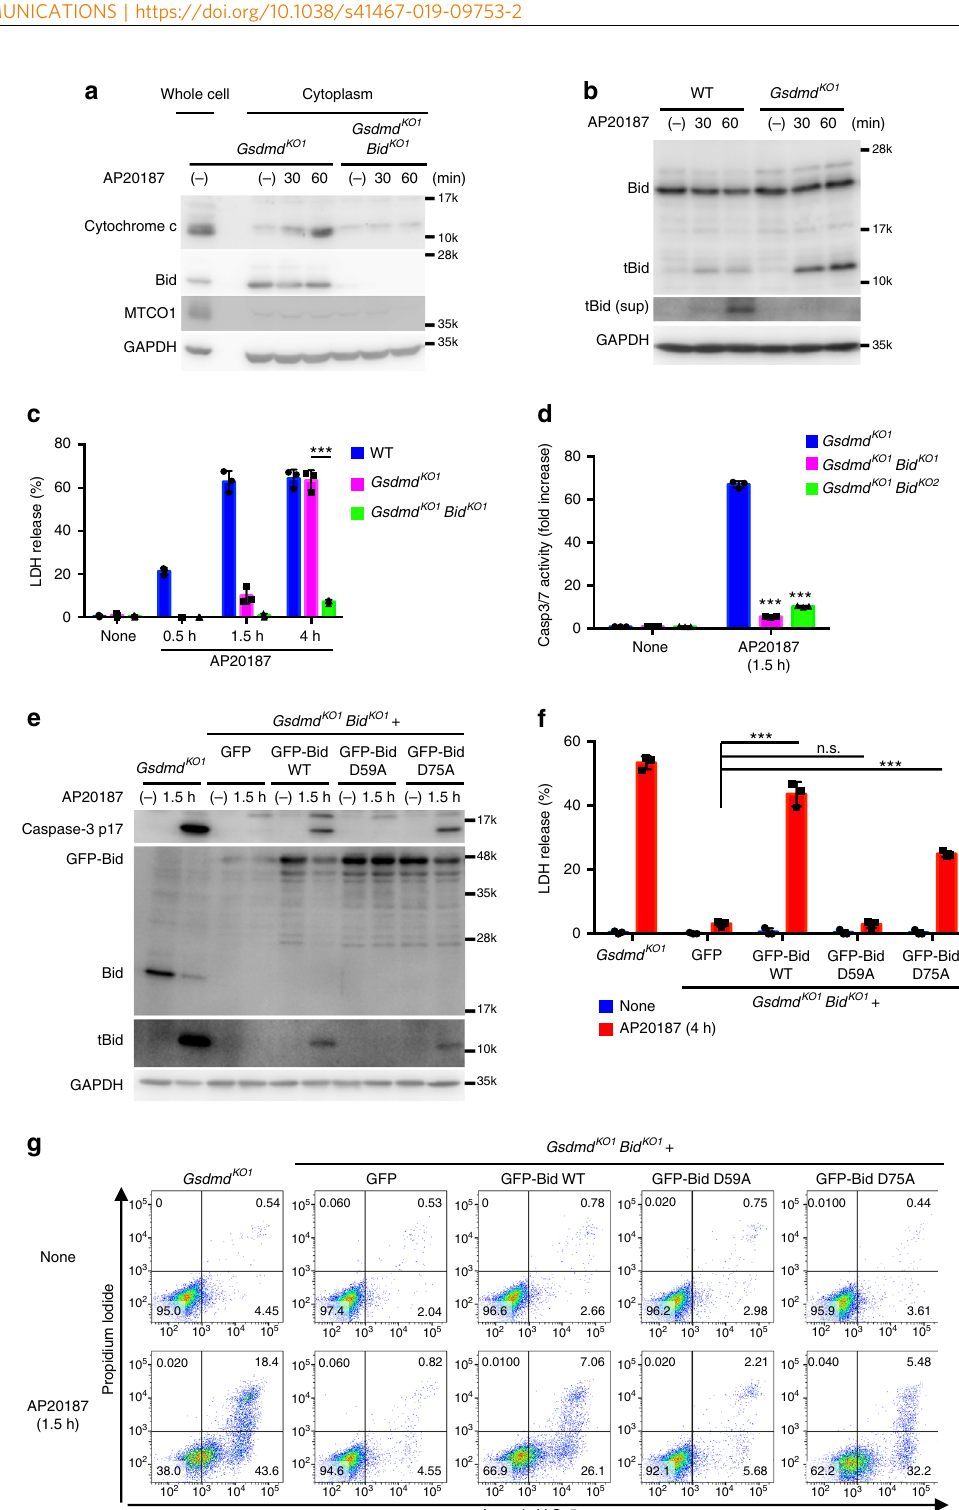
Fig. 6 Bid plays a critical role in caspase-1-induced apoptosis. a – d WT, Gsdmd -KO or Gsdmd / Bid -DKO CL26-iCasp1 cells were treated with AP20187 for the indicated times. Cytochrome c, Bid, GAPDH (cytosolic marker) and MTCO1 (mitochondrial marker) in the whole cell lysates or cytosol fractions were detected by western blotting ( a ). Bid in the cell lysates and culture supernatants (sup) was detected by Western blotting ( b ). LDH release into culture supernatants ( c ). Caspase-3/7 activity in the cell lysates. e – g Gsdmd -KO CL26-iCasp1 cells and Gsdmd / Bid -DKO CL26-iCasp1 cells stably transfected with GFP, GFP-Bid, or GFP-Bid mutants were treated with AP20187 for the indicated times. Cleaved caspase-3 and Bid in cell lyesates were detected by western blotting ( e ). LDH release ( f ). Flow cytometric analysis of PI uptake and PS exposure ( g ). Percentages of Annexin V + cells are shown in Supplementary Fig. 9d. In c , d , and f , graphs depict the mean ± SD of triplicate cultures, and individual data values are plotted. Statistical signi fi cance was determined using the unpaired Bonferroni ’ s multiple comparisons test. n.s., not signi fi cant; *** p < 0.001. Data are from one representative of three independent experiments with similar results ( a – g ). Source data are provided as a Source Data fi le. (See also Supplementary Figs. 8 and